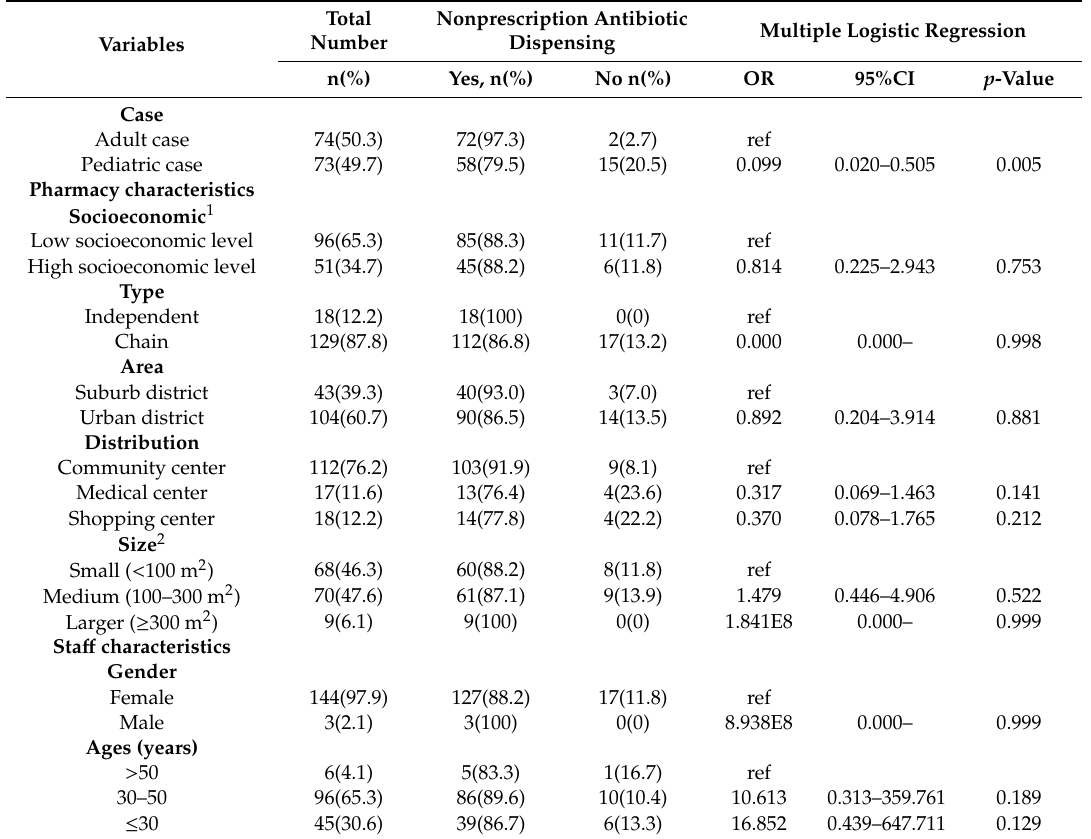
Table 1. Perceived characteristics of the visited pharmacies and respondent pharmacy sta ff and factors associated with non-prescription dispensing of antibiotics at community pharmacies in